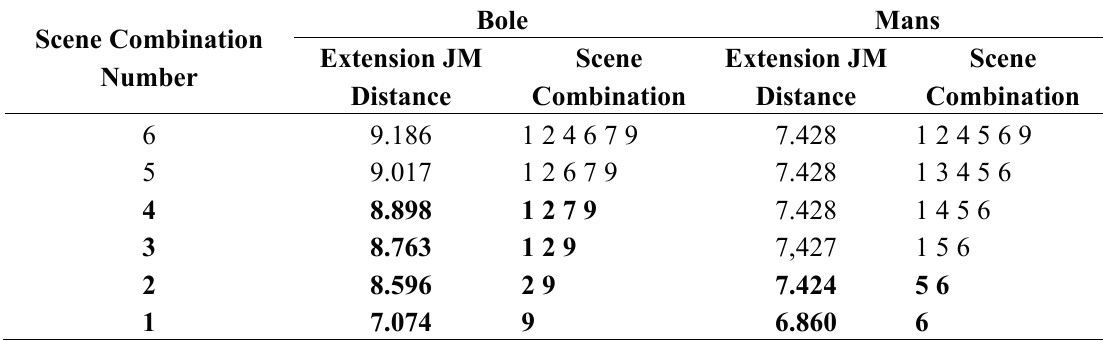
Table 7. Scenes combination and their extension of JM distances for the TM time series. Bole Mans Scene Combination Scene Number